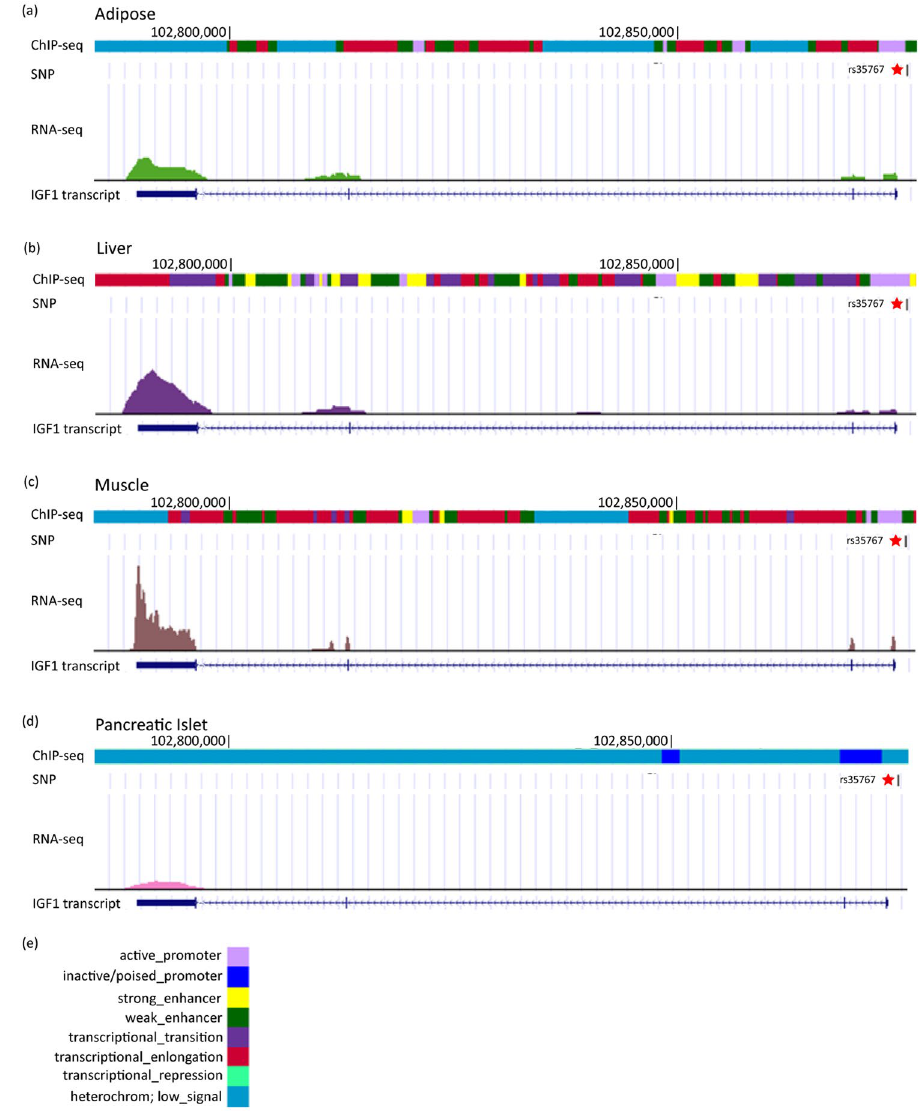
Figure 3. Genetic and epigenetic fine mapping of a well-known diabetic risk variant (rs35767) using iTEA. Panels a,b,c, and d show the genetic and epigenetic fine mapping of the diabetic risk SNP rs35767 in four tissue types: adipose ( a ), liver ( b ), muscle ( c ), and pancreas ( d ). We created four annotation tracks across ‘omic’ information for each tissue. The first track is a chromatin state track based on ChIP-seq data. The second is an SNP track; rs35767 is marked with a star. The third is a transcription track based on RNA-seq data. IGF1 transcript is shown for specific genomic region along with the RNA-seq and ChIP-seq signal. The diabetic risk SNP rs35767 is located in active IGF1 promoter regions in adipose, liver and muscle samples. In accordance with the active chromatin signal, transcription is active in adipose, liver and muscle samples. Panel (e) is the legend for panels a-d. Light violet indicates active promoter regions; blue indicates the inactive promoters; yellow and green indicate the strong and weak enhancers, respectively; purple, dark pink, and cyan indicate the transcriptional transition, elongation and repression, respectively; dark cyan indicates the low-signal regions. The eight colours correspond to eight diverse chromatin states (active promoter, inactive promoter, transcriptional transition, transcription elongation, strong enhancer, weak enhancer, transcriptional repression, and heterochromatin) as defined by ChromHMM 59 using 7 histone modification marks (H3K4me1, H3K4me3, H3K9ac, H3K9me3, H3K27ac, H3K27me3, and H3K36me3). In this study, we used H3K27ac to indicate enhancers and only assessed the influence of this histone modification across the reference